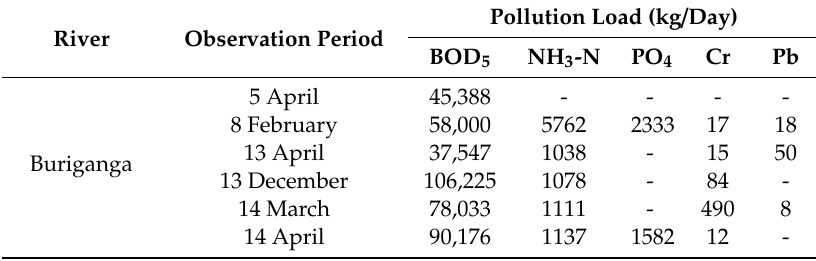
Table 5. Pollution loads in